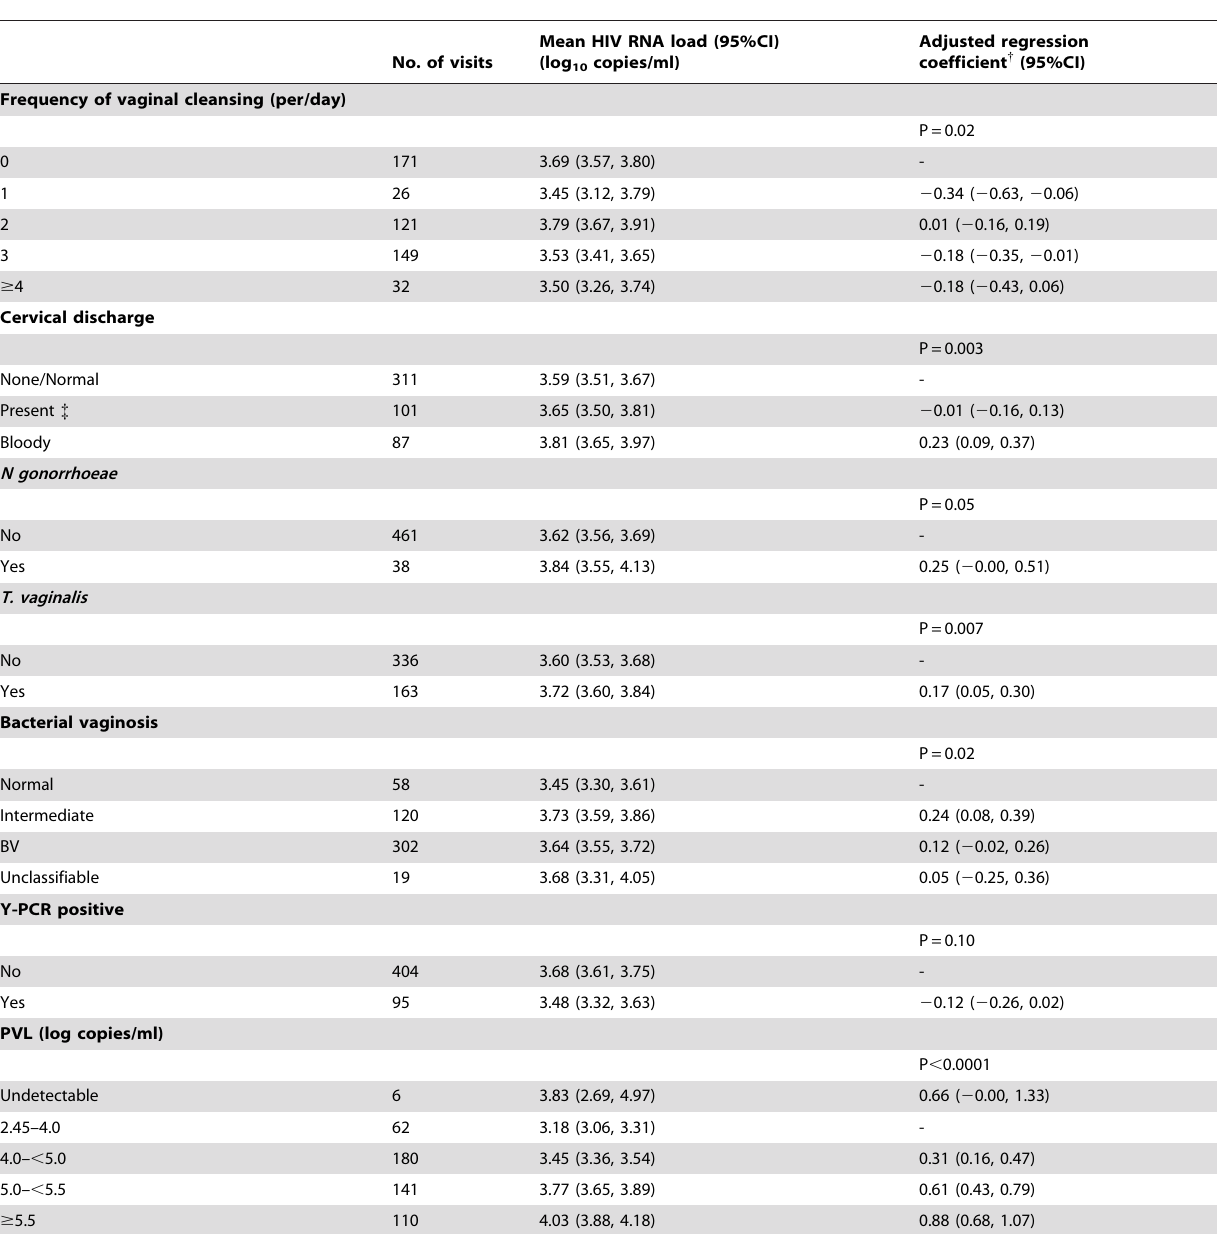
P values calculated using Wald test. *Adjusted for all variables in the table. { White, cream or purulent.